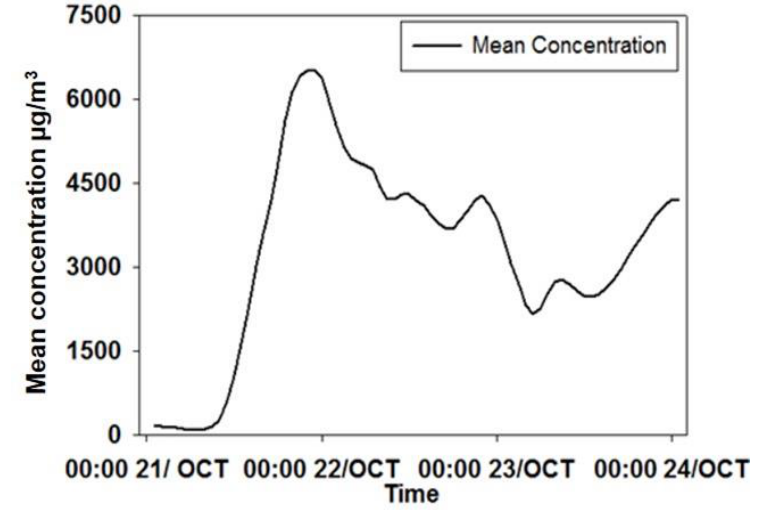
Figure 6. Time series of mean total dust concentration simulated in the 10 m above the north of the Gulf of California. Atmosphere 2020 , 11 , x FOR PEER REVIEW 11 of 22